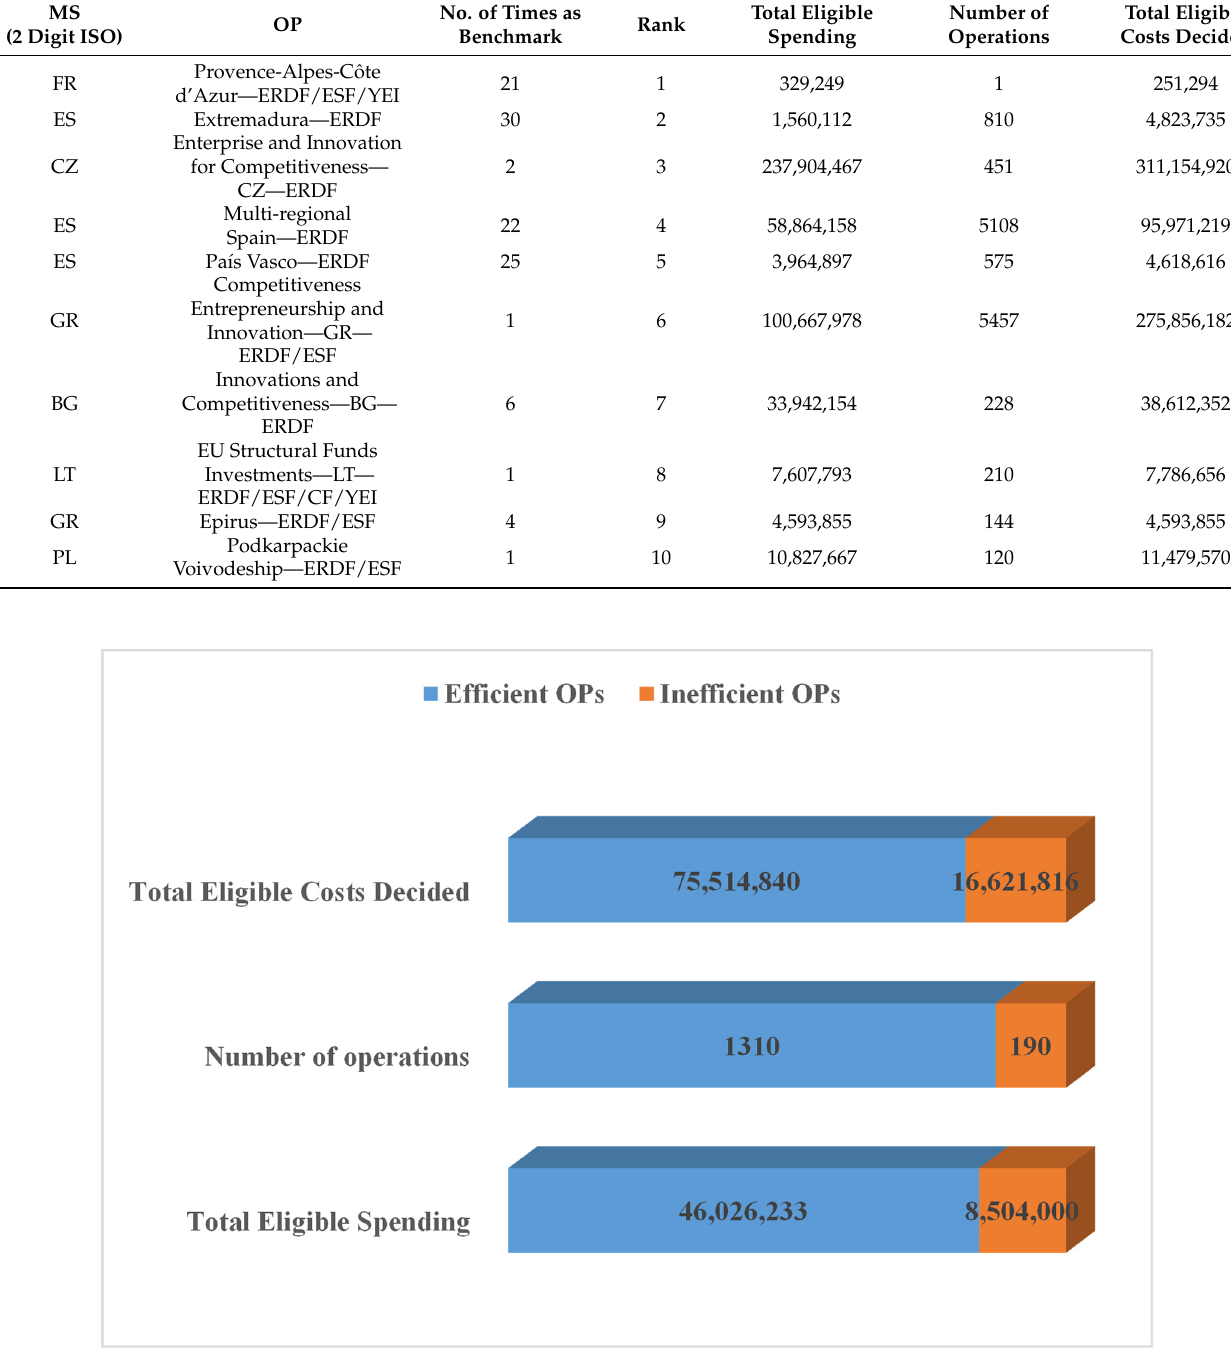
Figure 2. Average input and output values attained for the efficient and inefficient OPs.